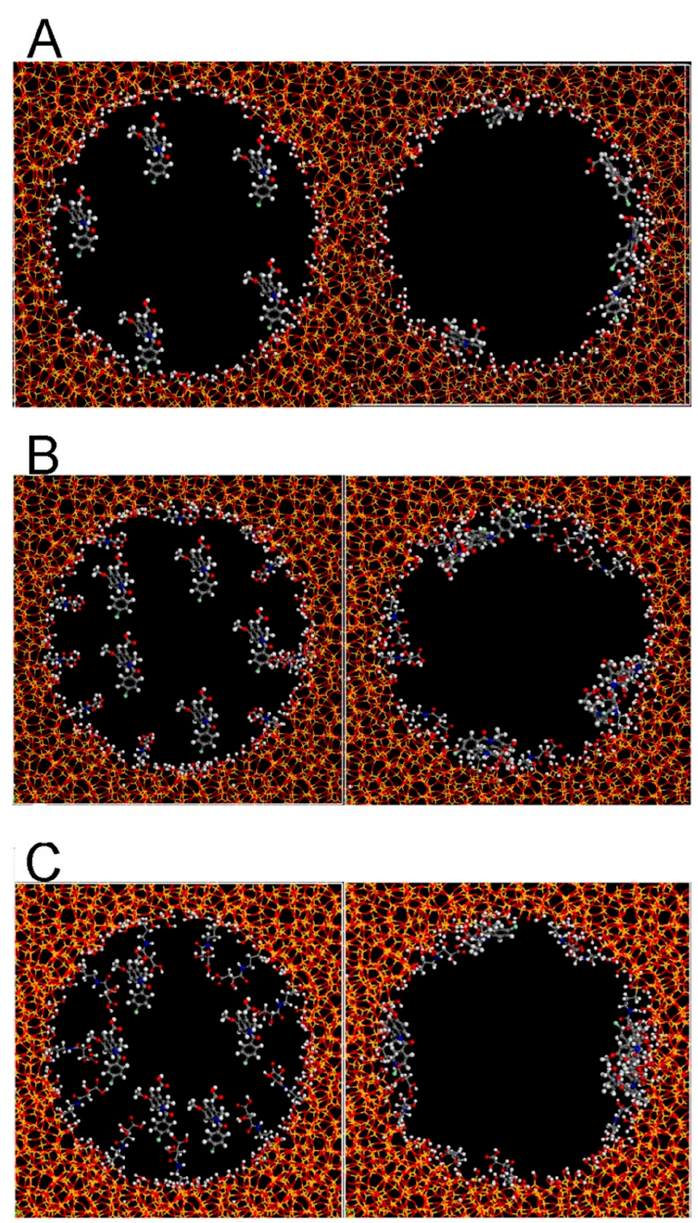
Figure 9. Molecular Simulation results of ( A ), IMC loaded N -MSN; ( B ), IMC loaded Cb- d -MSN; ( C ), IMC loaded Cb- l -MSN. Credit: republished with permission of Elsevier, from Reference [50], Copyright (2018), with permission conveyed through Copyright Clearance Center,